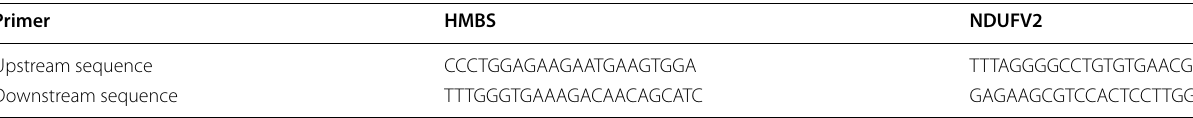
Table 1 qRT-PCR reaction system: primers used to amplify mRNA Primer HMBS NDUFV2 Upstream sequence Downstream sequence